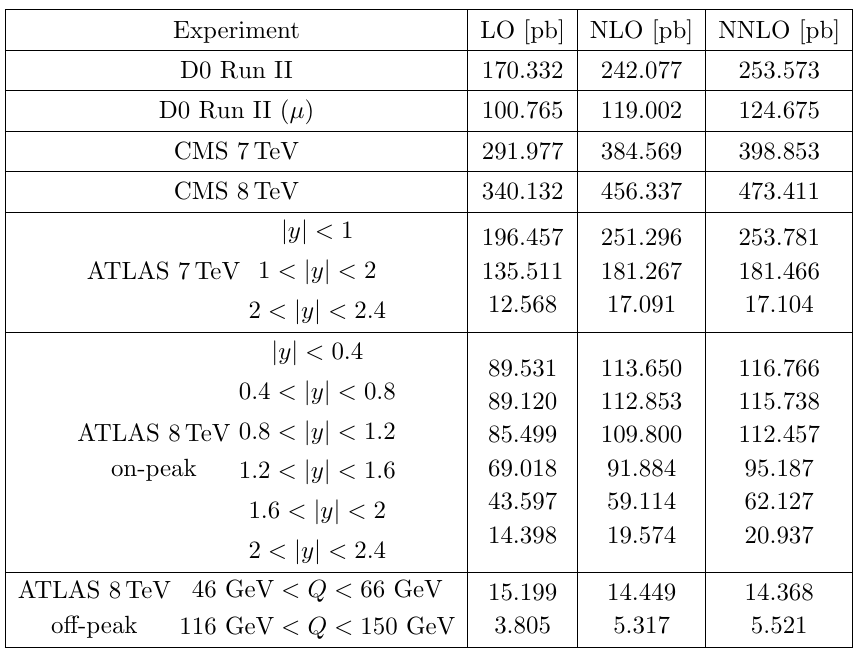
Table 3 . Total ((cid:12)ducial) cross sections computed with DYNNLO [94, 95] using the central member of the MMHT2014 collinear PDF sets [54] and required for the computation of the normalised di(cid:11)erential cross sections at the di(cid:11)erent perturbative